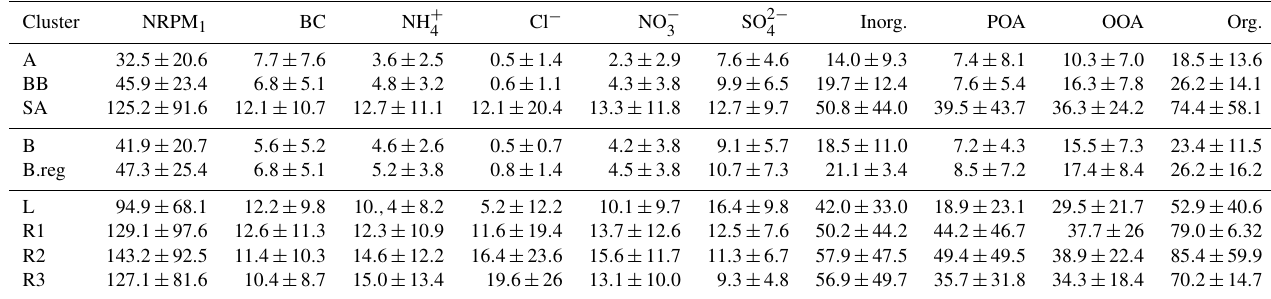
Table 1. Mean values of NRPM 1 species and BC (µgm − 3 ) for all